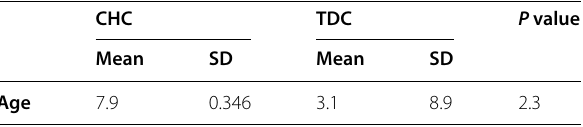
Table 1 Age of the congenital hypothyroid children (CHC) and typically developing children